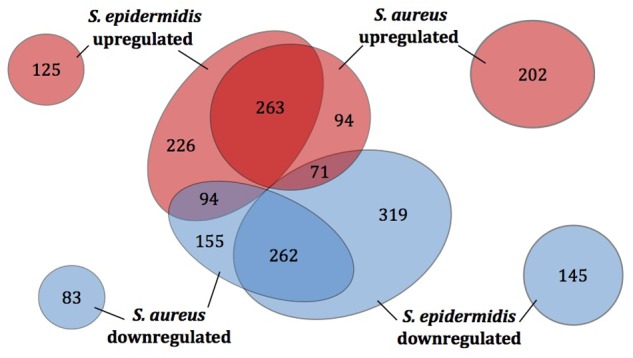
Differentially expressed genes of S. aureus and S. epidermidis post challenge with sapienic acid. The number of homologous genes of S. aureus Newman and S. epidermidis Tü3298 (central circles) that were upregulated (red) or downregulated (blue) following sapienic acid challenge were compared. Numbers of upregulated and downregulated genes with no homologue in the other species are shown by the outer circles.